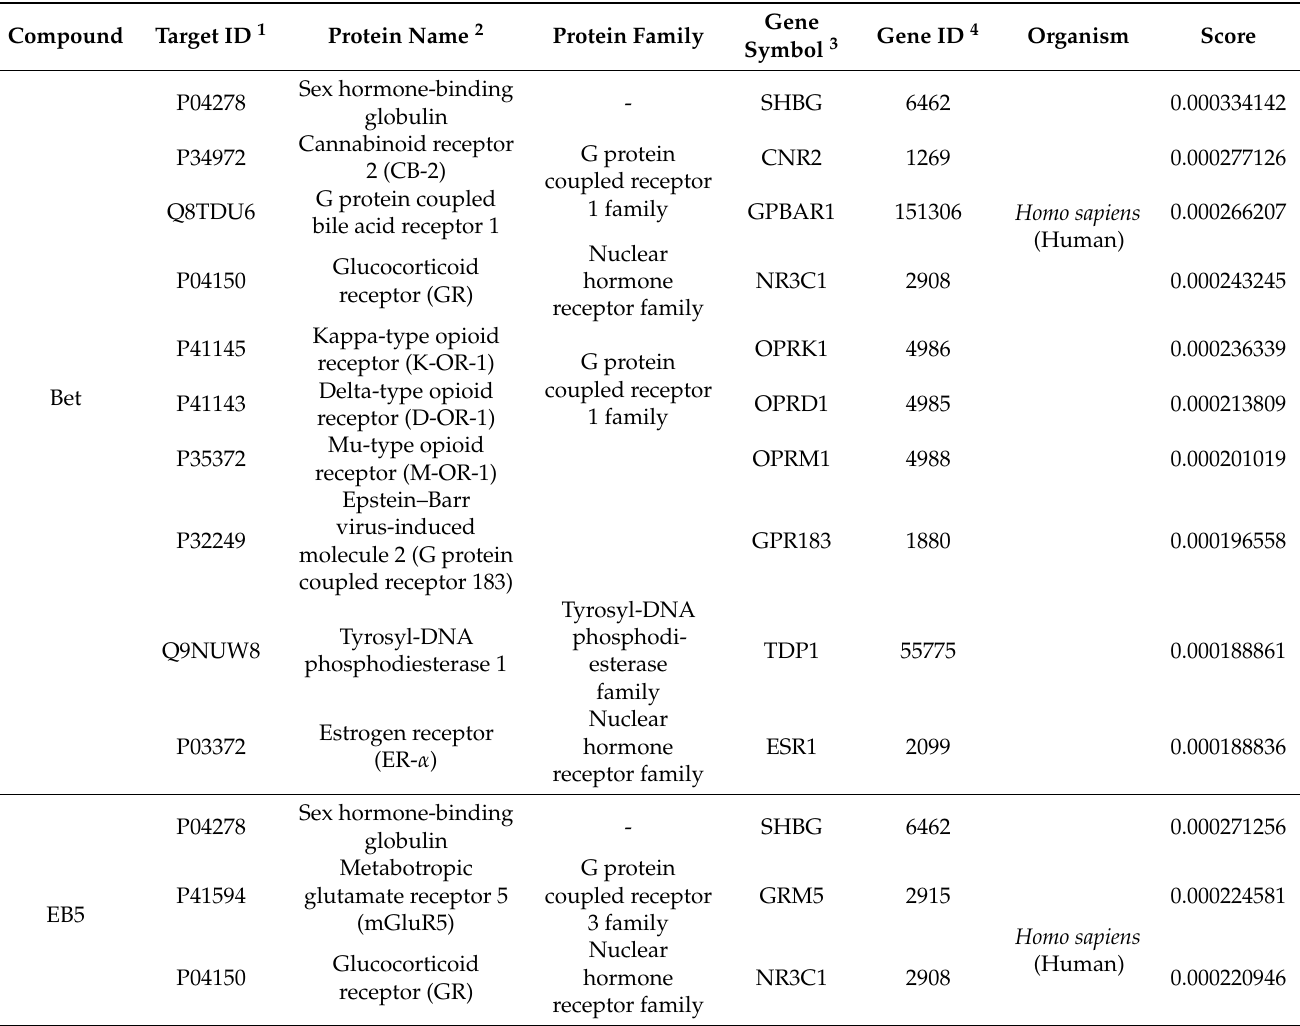
Table 5. Prediction of target proteins for ASBDs—computational